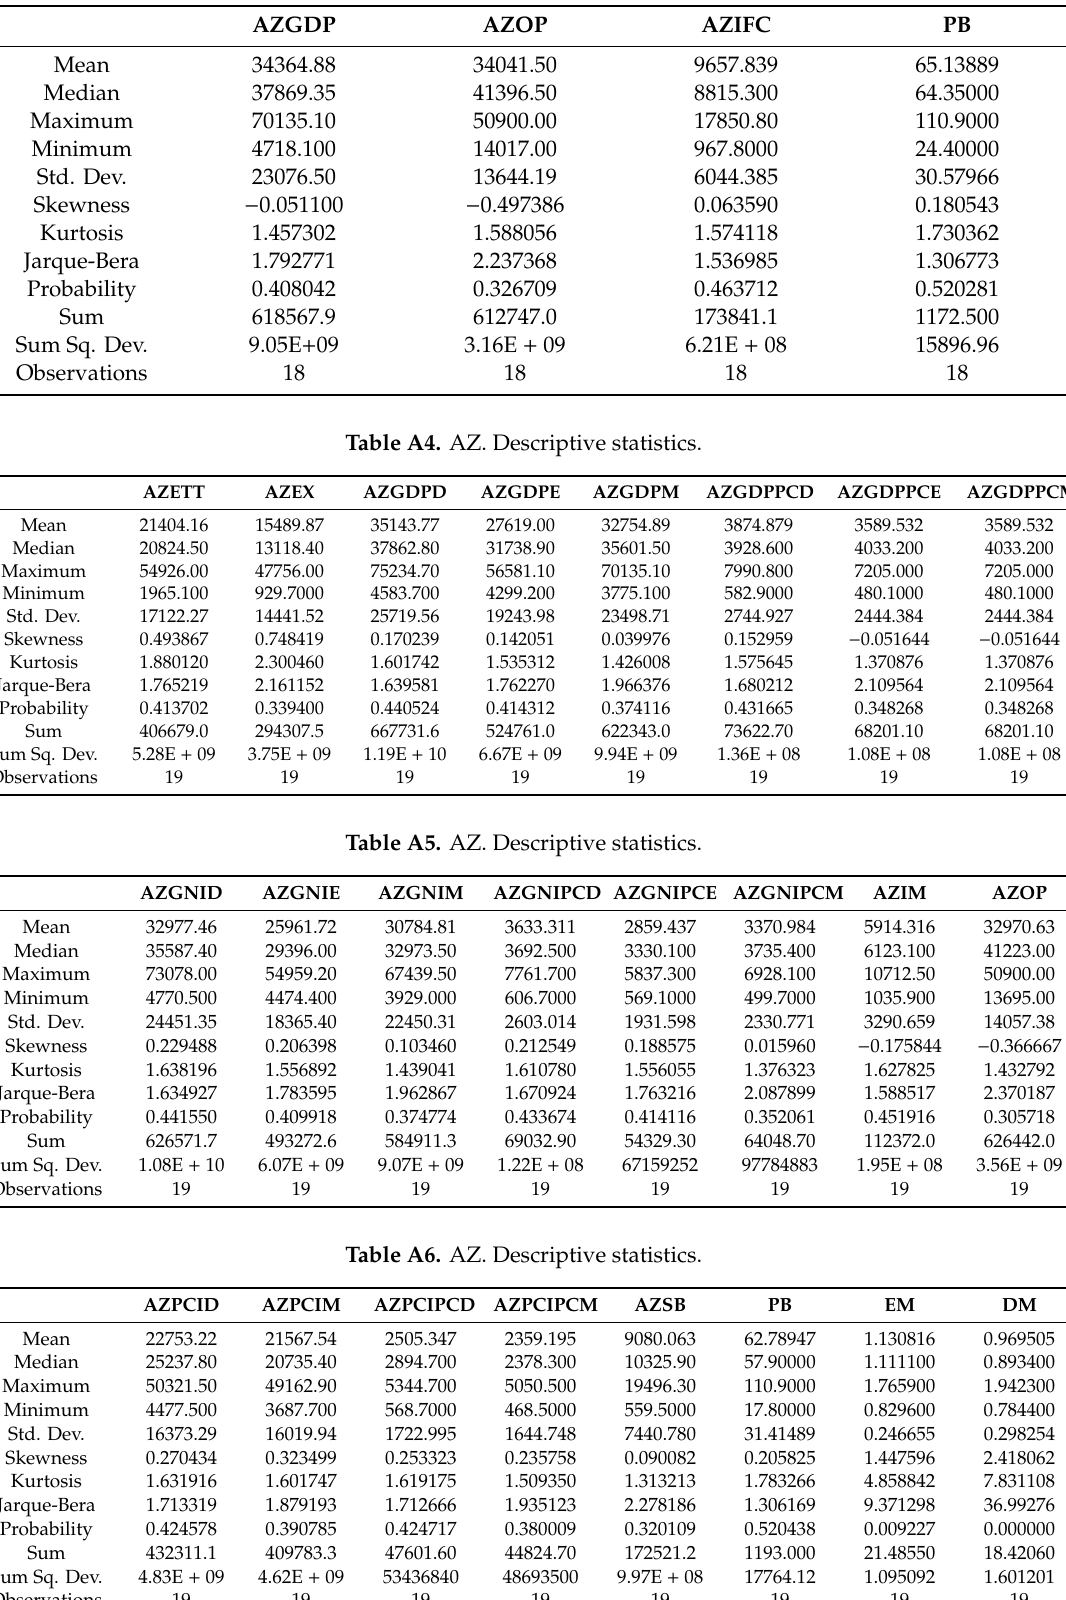
Table A3. AZ. Descriptive statistics.